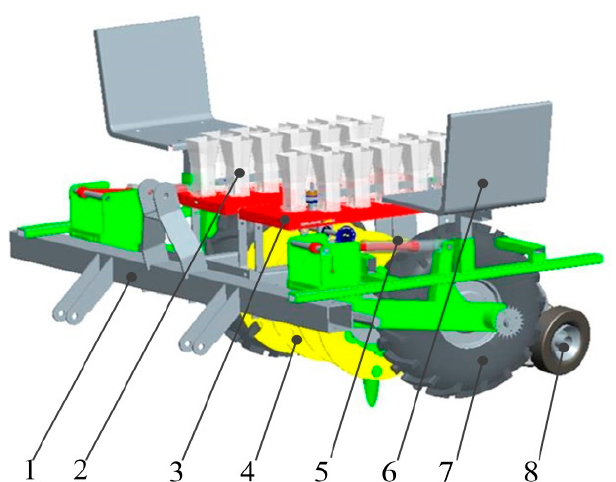
Figure 1. Three ‐ dimensional model diagram of the transplanter. 1. Main beam; 2. feeding cup; 3. feeding mechanism; 4. planting mechanism; 5. planting depth adjusting for mechanism; 6. seat; 7. ground wheel; and 8. the earth ‐ covering roller.